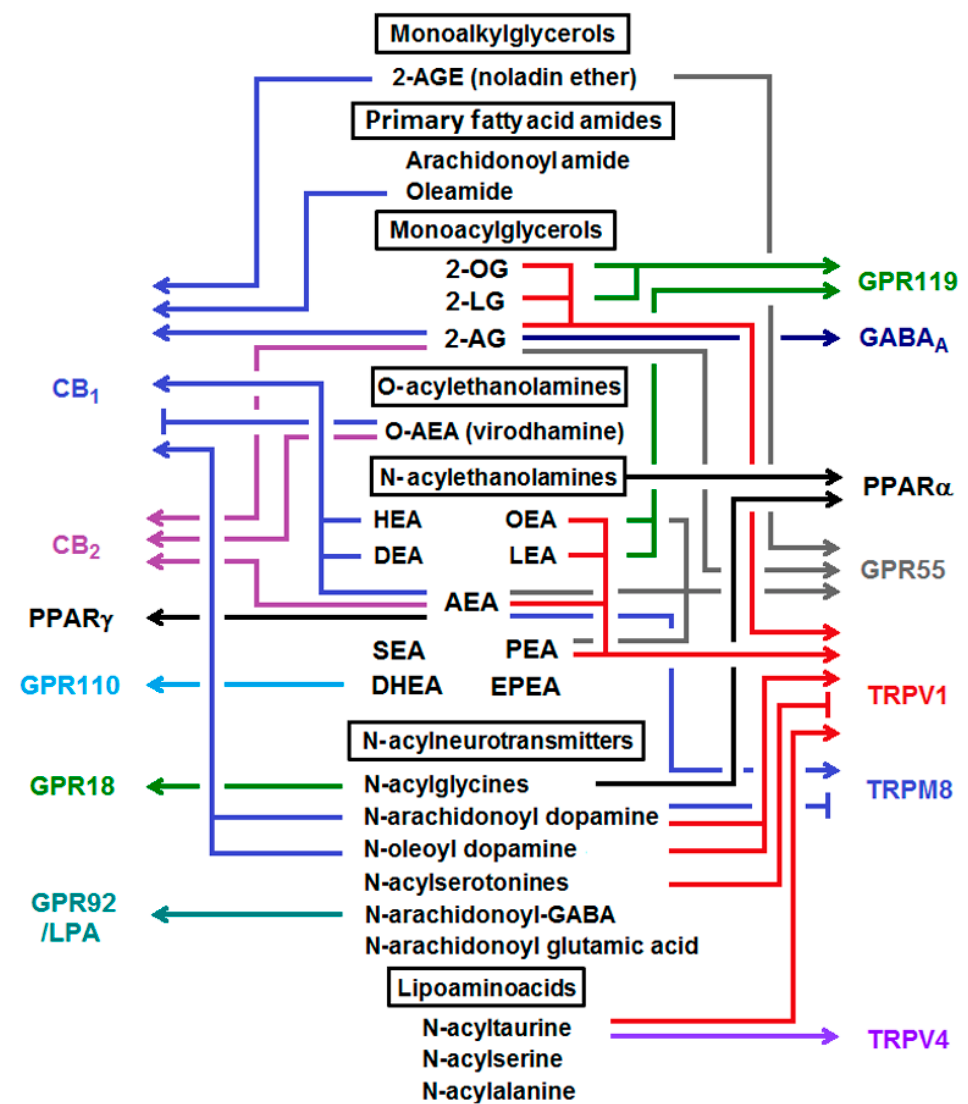
Figure 2. The endocannabinoids(eCBs), related compounds and their molecular targets. Major eCBs are monoacylglycerols (such as 2-arachidonylglycerol), N-acylethanolamines (such as arachi- donoylethanolamide), lipoaminoacids, N-acylneurotransmitters or primary fatty acid amides, and have different affinity for cannabinoid receptors (CB) 1/2 , non-cannabinoid G-protein coupled recep- tors (GPRs), and transient receptor potential cation channel subfamily V member 1 and 4 (TRPV1 and TRPV4). 2-AGE, 2-arachidonyl glyeryl ether (nolandin ether); DEA, docosatetraenoylethanolamide; DHEA, docosahexaenoylethanolamide; EPEA, eicosapentaenoylethanolamide; HEA, homo- γ -linolenylethanolamide; LEA, linoleylethanolamide; 2-LG, 2-linoleoylglycerol; LPA5, lysophosphatidic acid receptor 5; OEA, oleoylethanolamide; 2-OG, 2-oleoylglycerol, PEA, palmitoylethanolamide; SEA, stearoylethanolamide; TRPM8, transient receptor potential cation channel subfamily M (melastatin) member 8.